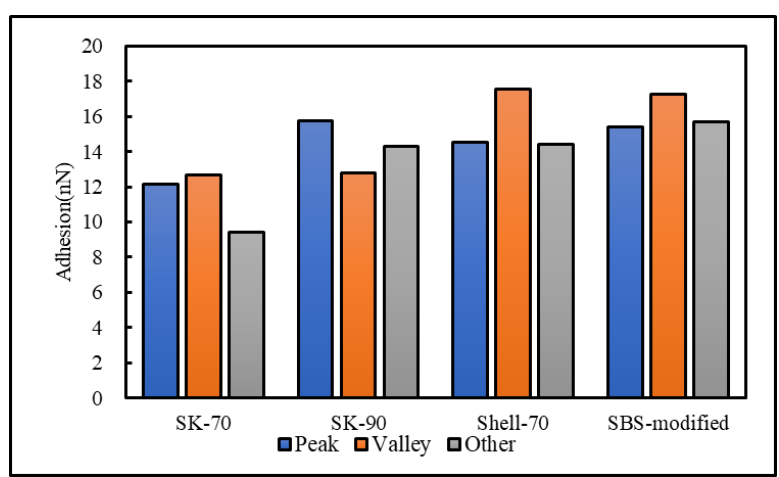
Figure 13. Surface energies of different regions in the aged asphalts.